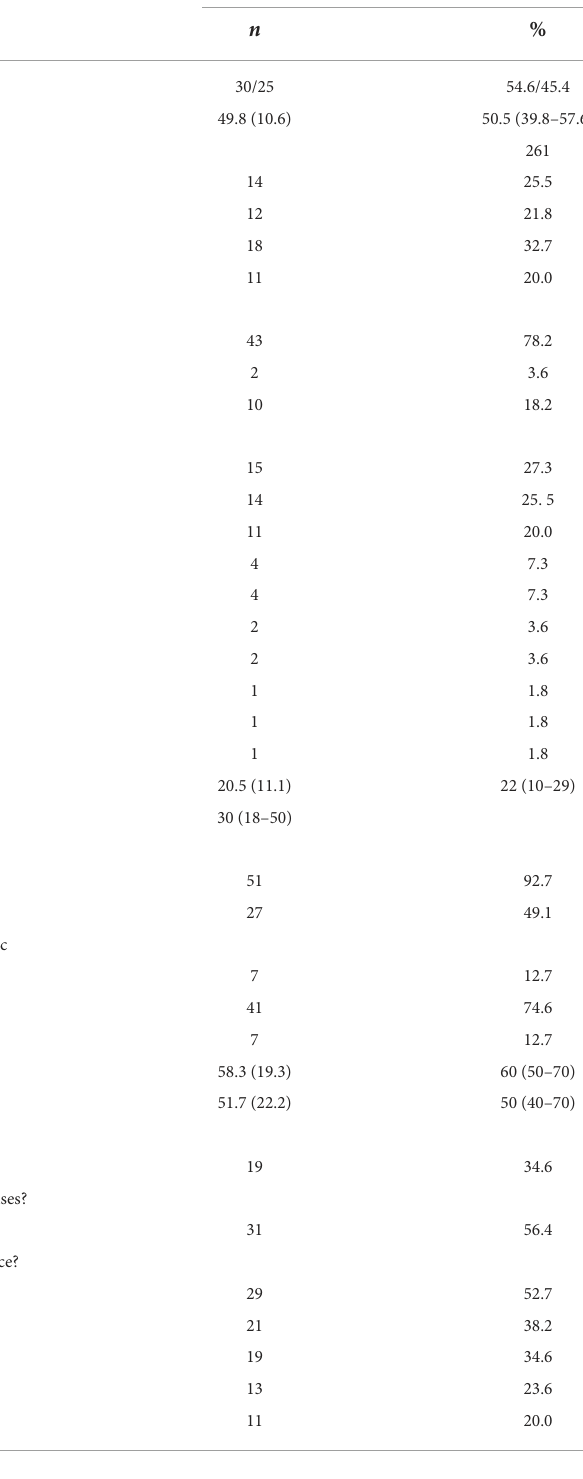
TABLE 1 Baseline demographic and occupational characteristics of the study